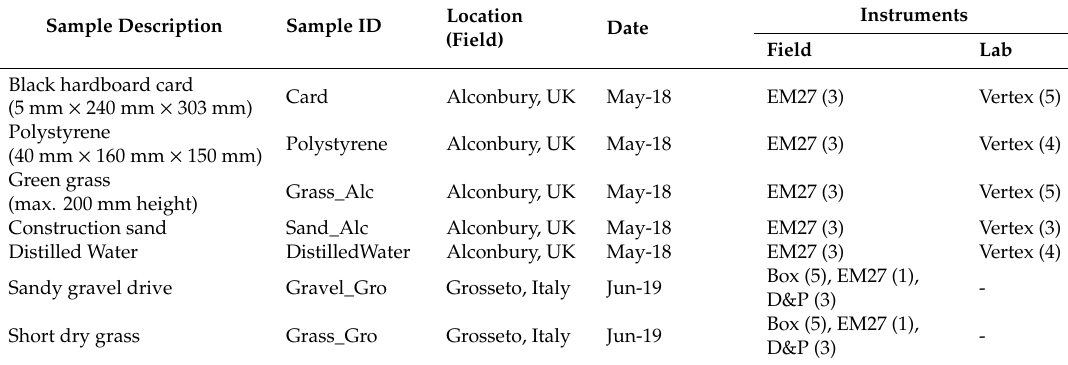
Figure 7. All samples considered in this study other than distilled water. Samples ( a ) to ( d ) were measured for the Alconbury comparison and show ( a ) black hardboard card on the tarmac, ( b ) construction sand, ( c ) green grass in Alconbury, and ( d ) polystyrene. Samples ( e ) to ( l ) were measured in Italy, with ( e ) the beach near Grosseto from where sand was collected, ( f ) the short green grass in Grosseto, ( g ) the gravel drive in Grosseto with emissivity box pictured, ( h ) a close-up the grey tarpaulin in Grosseto, ( i ) the white, grey and black tarpaulin photographed from the plane in Grosseto, Italy while in use as calibration targets, ( j ) gravel in Duxford during measurement, ( k ) green grass in Duxford, and ( l ) tarmac in Duxford. Table 4. Samples considered for the field and laboratory emissivity inter-comparison, with the number of measurements made using each indicated in brackets in the final column. Note that the three tarpaulins were measured by the EM27 in both Duxford (UK) and Grosseto (Italy).